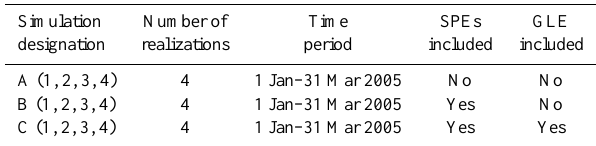
Fig. 2. Daily average ion pair production rates (cm − 3 s − 1 ) com- puted for the “SPEs-only” case (solid line) and the “SPEs+GLE” case (dashed line) on 20 January 2005. Table 1. Description of WACCM3